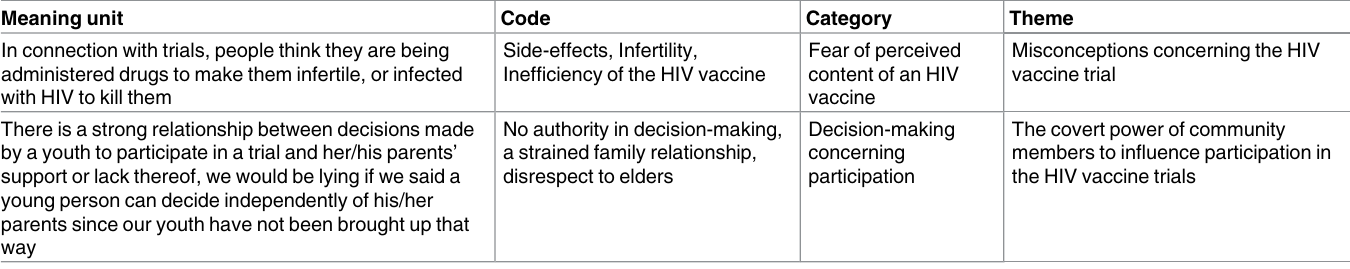
Table 1. An example of our qualitative content analysis. Meaning unit Code Category